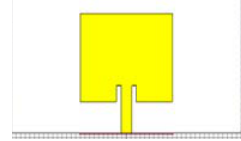
Figure 1: Element of the array